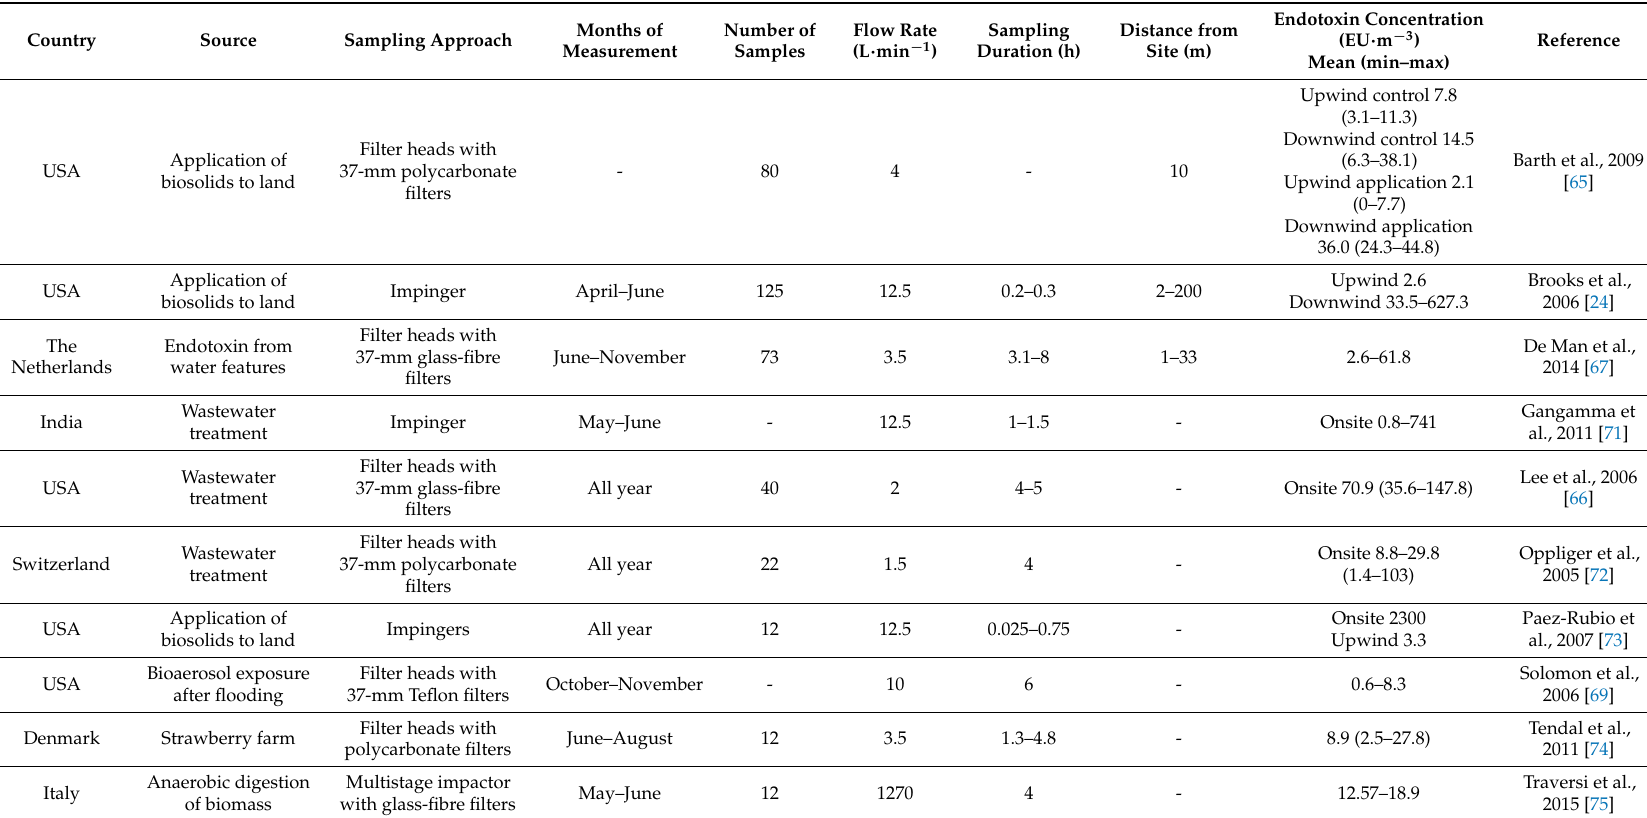
Table 4. Endotoxin emissions from other sources as reported in the